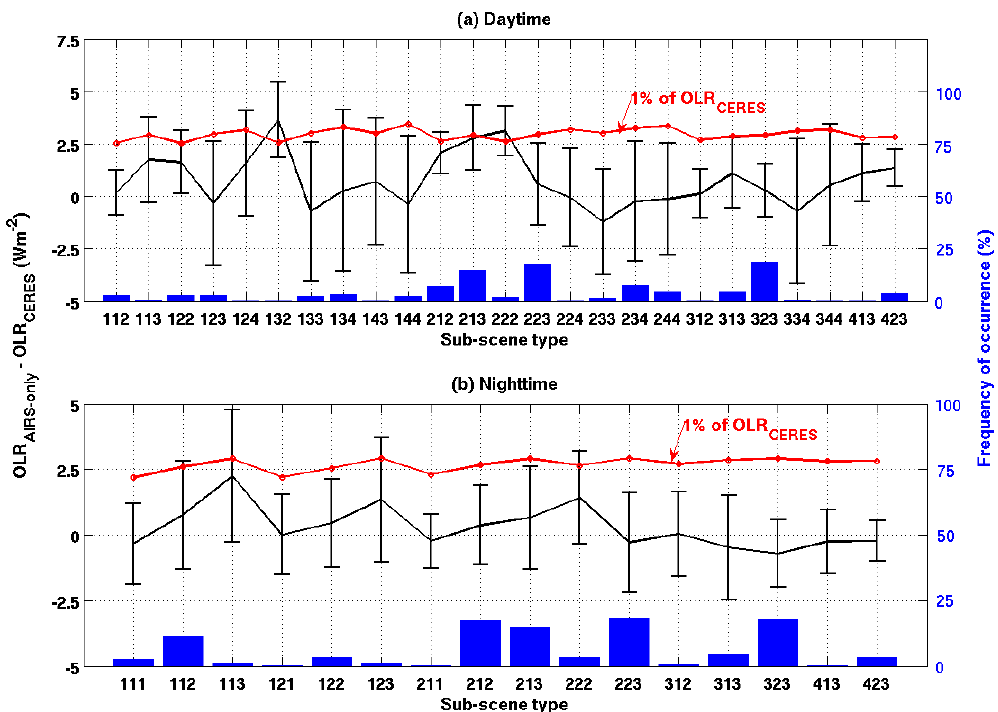
Figure 5. (a) Black line denotes the mean of daytime OLR difference (OLR AIRS-only –OLR CERES ) for each sub-scene type. Ticked vertical lines denote ± 1 σ (standard deviation). Red line is the uncertainty of OLR CERES (assuming 1% of mean OLR CERES for all scene types). Blue bars indicate the frequency of occurrence of each sub-scene type in percentage. (b) Same as (a) but for nighttime observations. The numbers of daytime and nighttime observations are 1 . 86 × 10 5 and 1 . 87 × 10 5 , respectively.